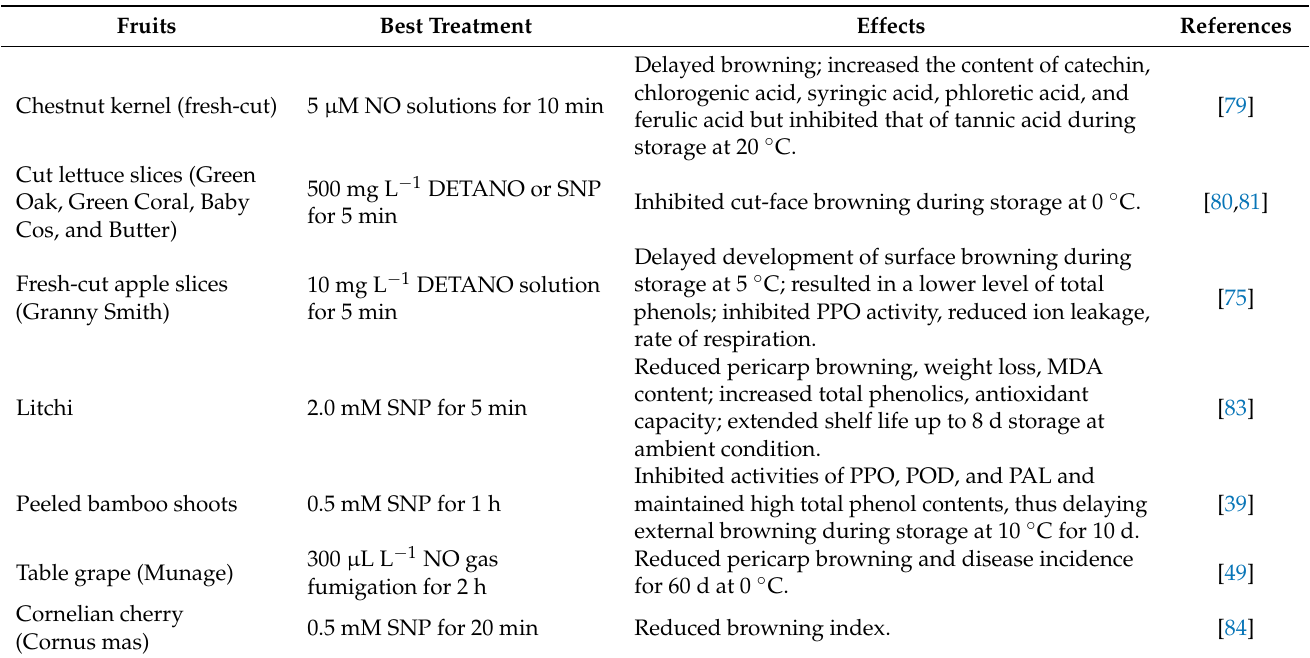
Table 4. The effects of NO on